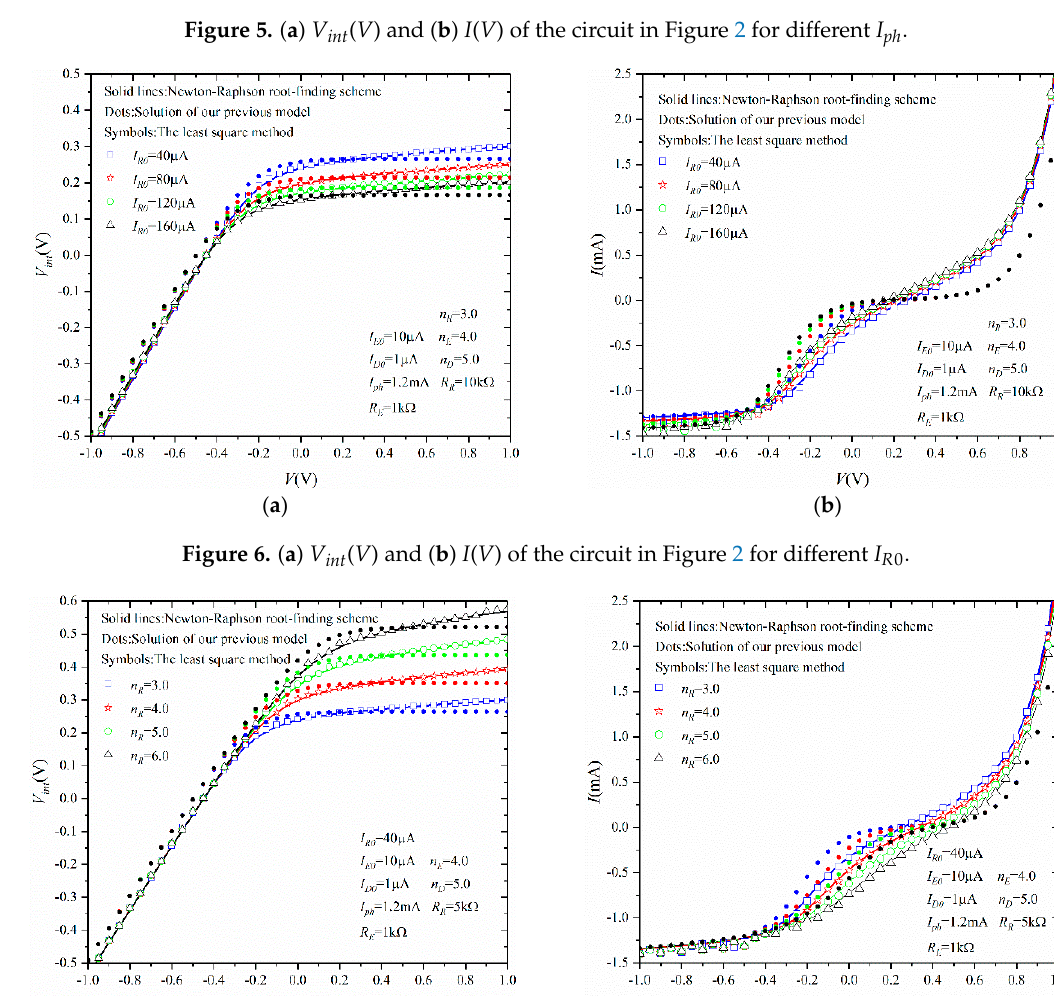
Figure 5. ( a ) V int ( V ) and ( b ) I ( V ) of the circuit in Figure 2 for different I ph . Catalysts 2019 , 9 , x FOR PEER REVIEW